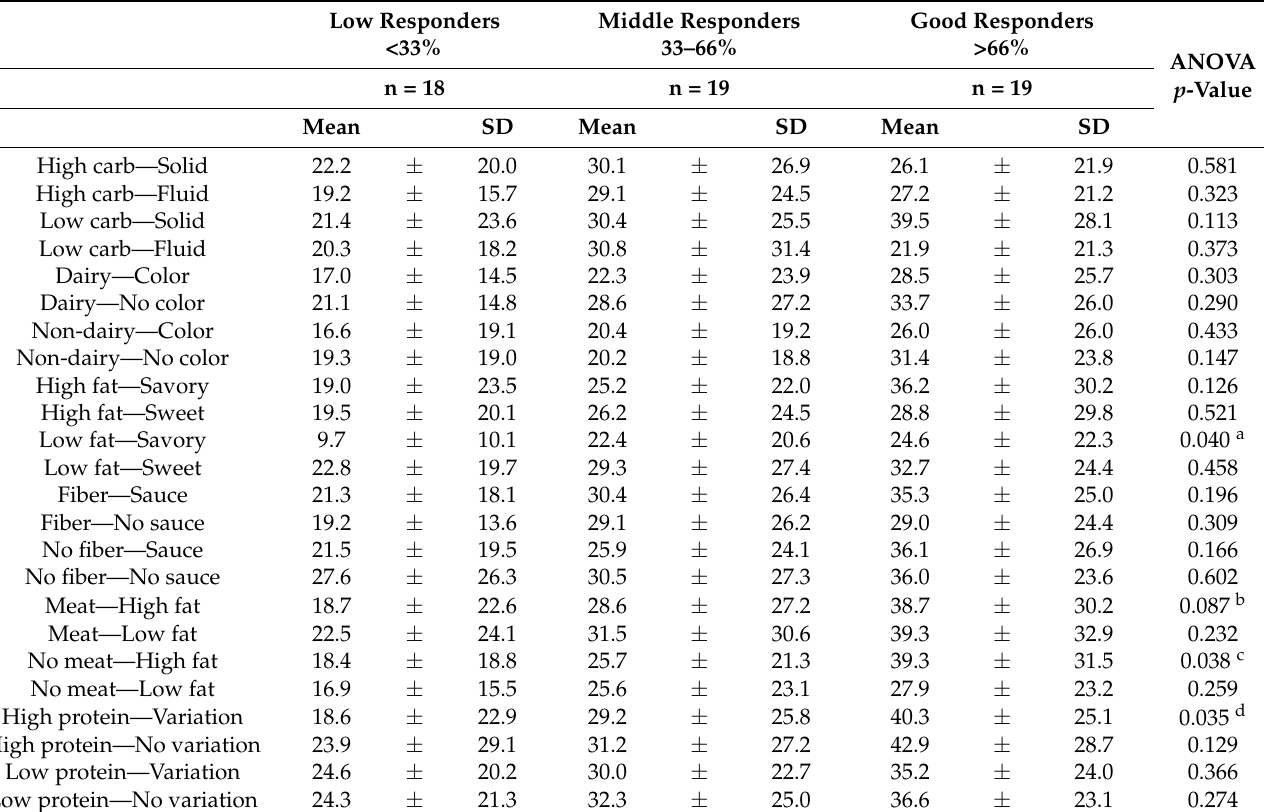
Table 3. Relationship between explicit liking for foods regarding percentage of total weight